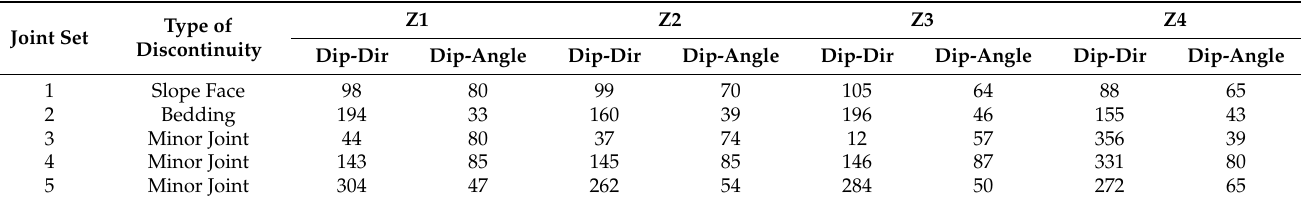
Table 2. Principal orientations of discontinuities extracted from source sectors in the 2019 SfM point cloud.